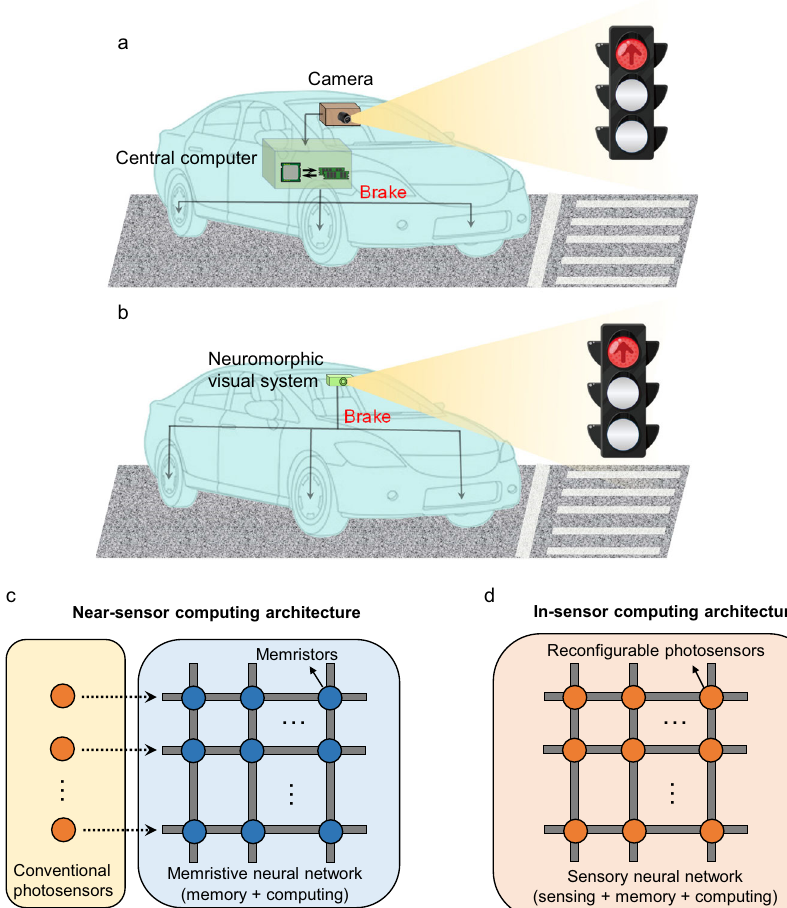
Fig. 1 Hardware implementations of machine vision. Schematics for a conventional Von Neumann system and b emerging neuromorphic visual system. c Near- and d in-sensor computing architectures for the neuromorphic visual system. The proposed FE-PS-NET uses the architecture shown in d , where FE-PSs act as recon fi gurable